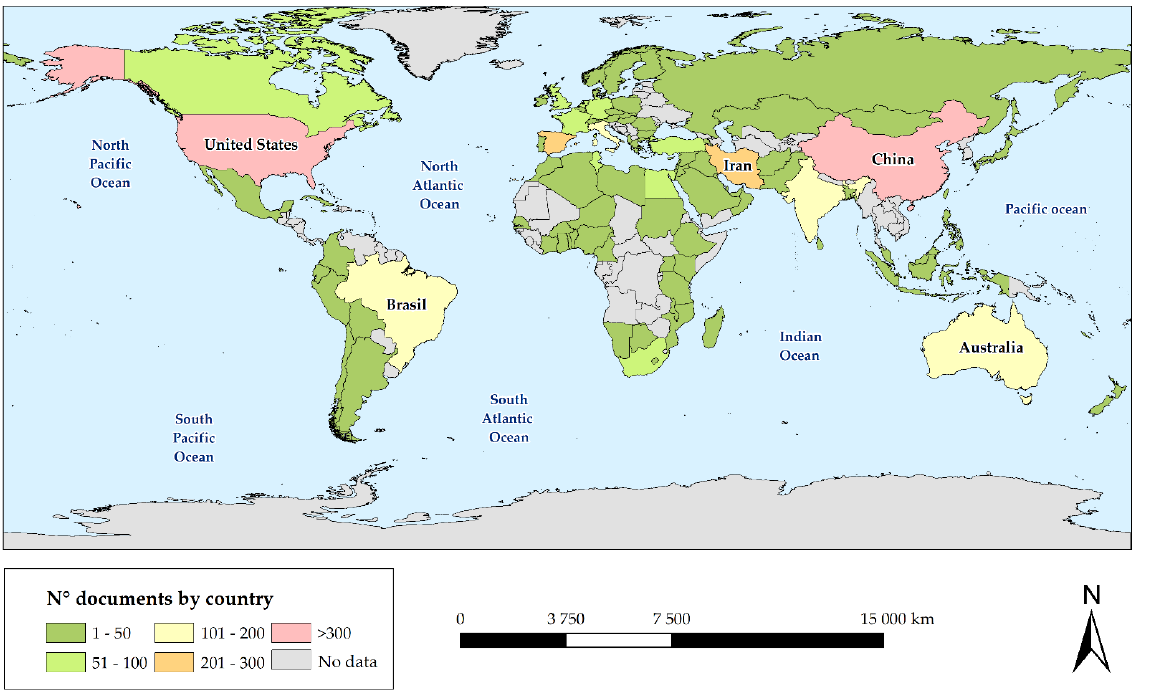
Figure 4. Distribution of scientific production by country.